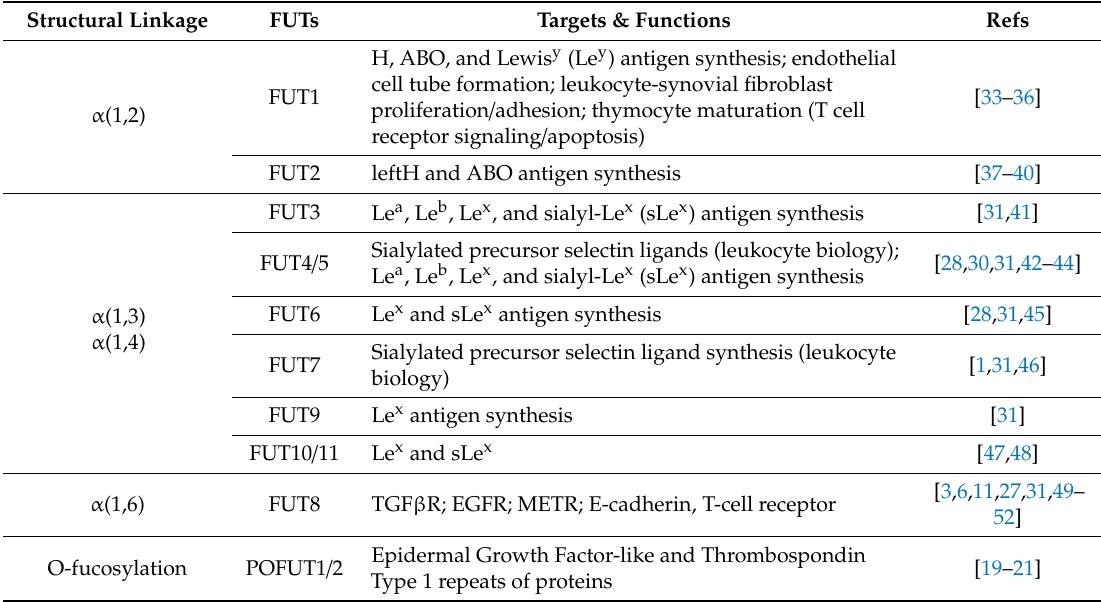
Table 2. Fucosylation linkages, associated FUTs, and targets